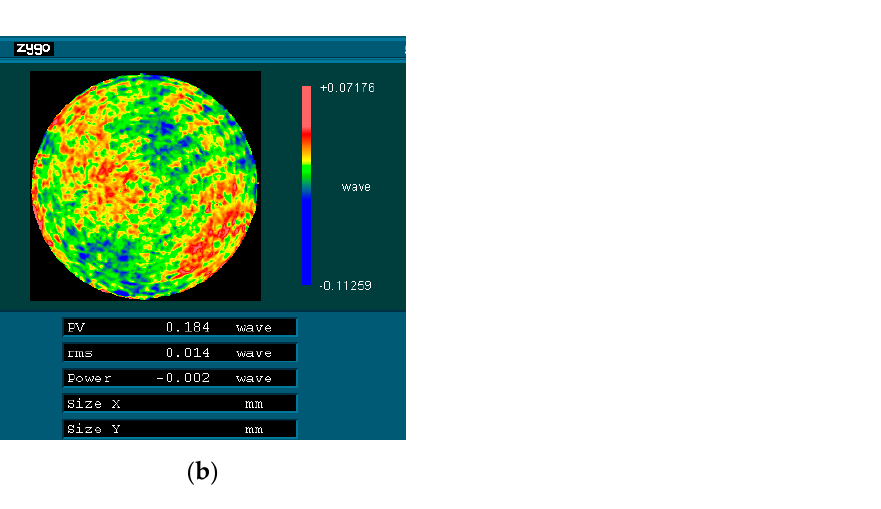
Figure 16. ( a ) Surface profile before coating. ( b ) Surface profile after coating.